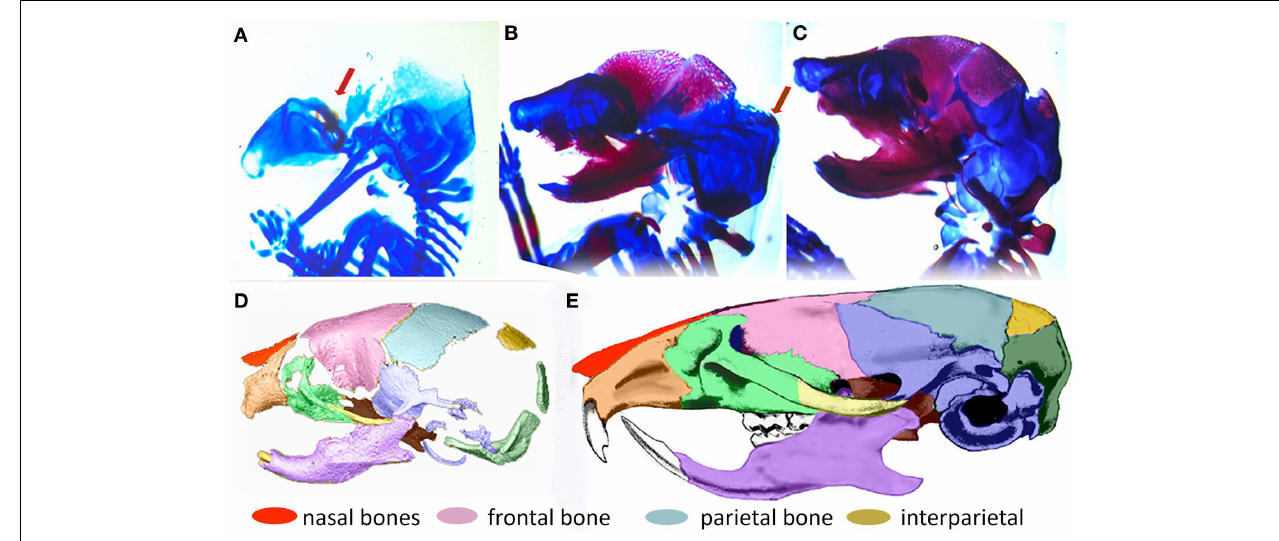
are clearly visible and the ossification of the interparietal bone is beginning (arrow); (C) By E17.5, the interparietal is well formed and other bones of the skull are clearly visible. (D) 3D reconstruction of micro computed tomography image of the mouse skull at birth (P0) colored to indicate the placement and level of maturity of all skull bones. (E) Adult mouse skull colored to show relative position of skull